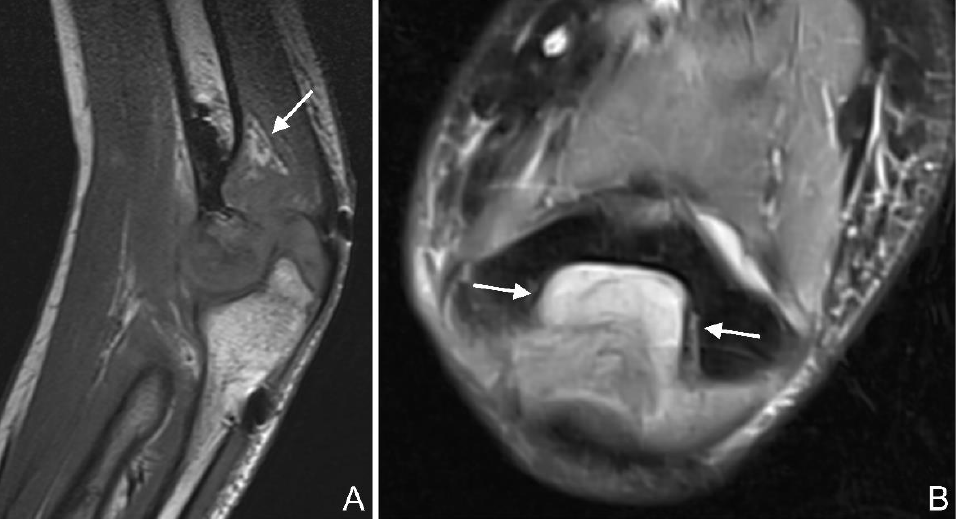
Figure 6. ( A ): T1 se (spin echo) sagittal image of the left elbow of a 17-year-old boy with a lateral humeral condyle fracture (arrow). The posterior fat pad is raised from the olecranon fossa, suggesting a joint effusion. ( B ): PD tse fs (proton density turbo spin echo fat-saturated) transverse image of the left elbow of a 16-year-old girl with a coronoid process fracture. Hyperintense joint effusion (arrow) is seen in the olecranon fossa.